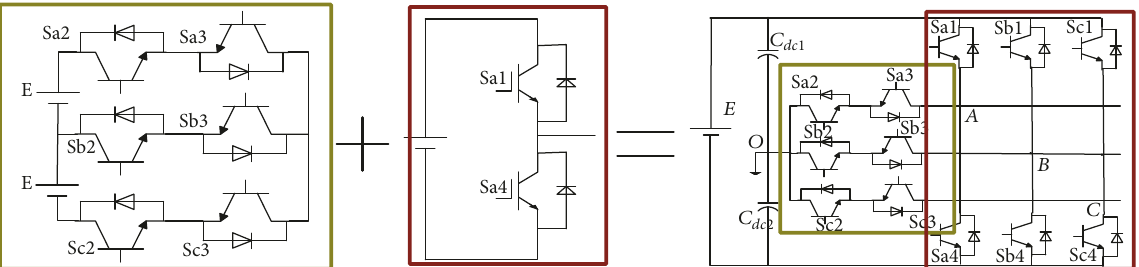
Figure 4: Parallel-series-connection topology of the different basic units.